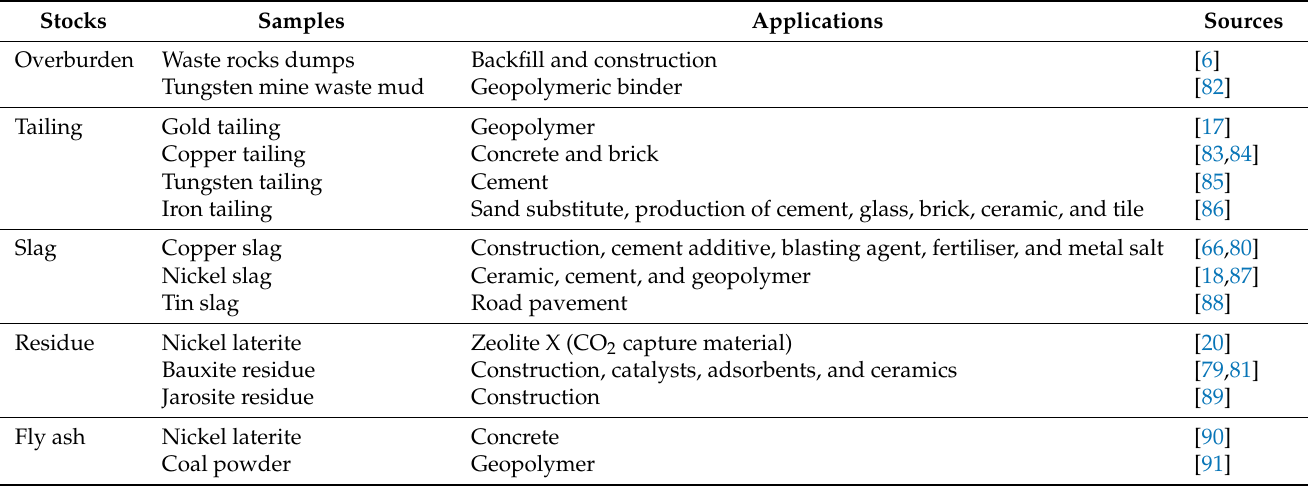
Table 3. Applications of technospheric stocks from the mining